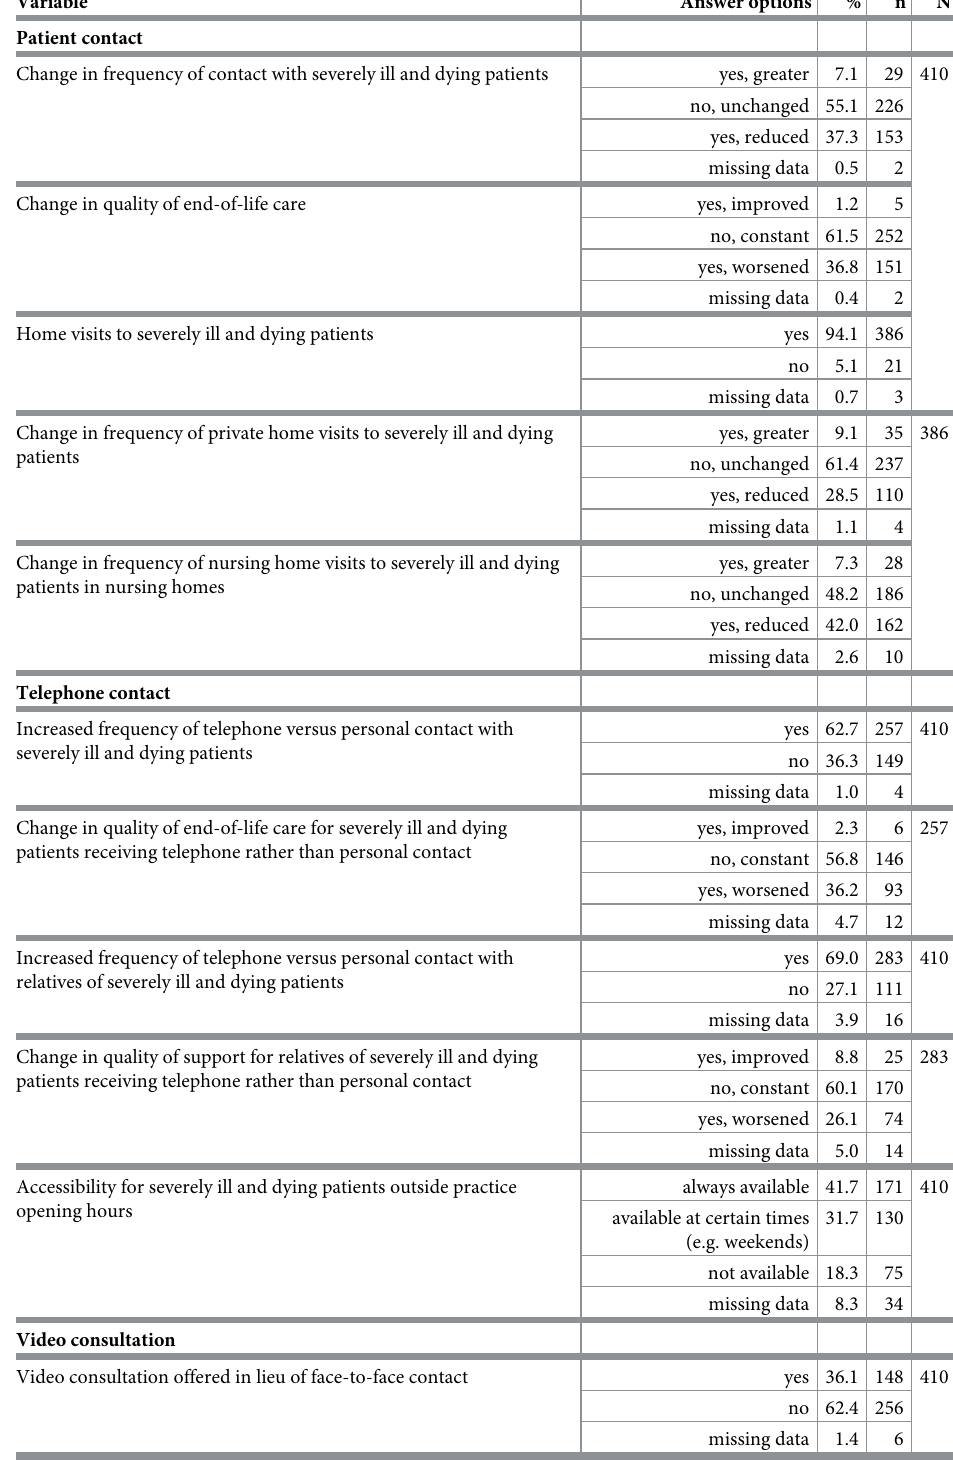
Table 2. Patient contact, telephone contact and video